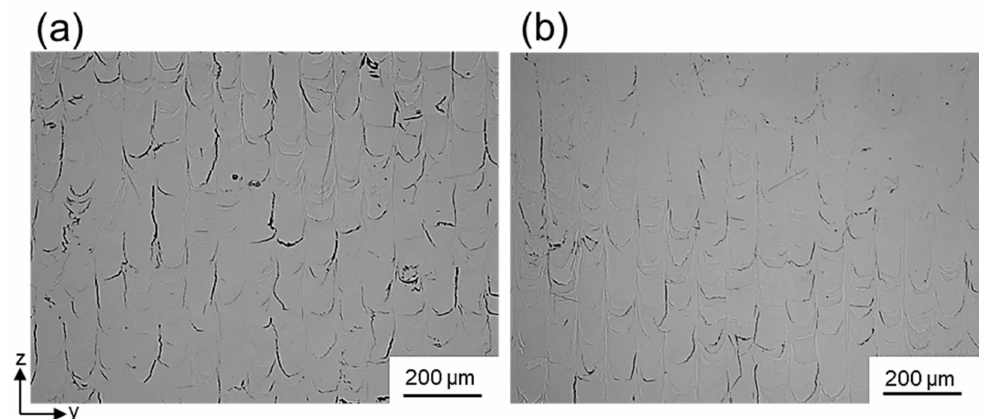
Figure 2. y–z Cross sectional images of as-built Cr specimens fabricated by LPBF with ( a ) 10 × 10 mm and ( b ) 5 × 5 mm scan